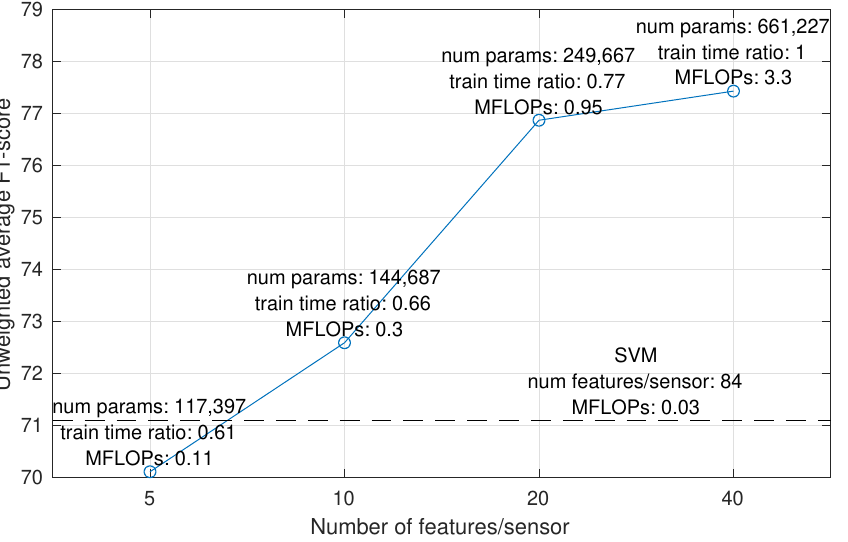
Figure 8. Effect of the number of bottleneck features for Conv2D-SI to the unweighted average F 1-score. The performance of the feature + SVM model is shown as a reference (dashed line). The computational complexity is expressed as the number of MFLOPs (mega floating point operations) required to perform the feature extraction within each sensor for a single frame of